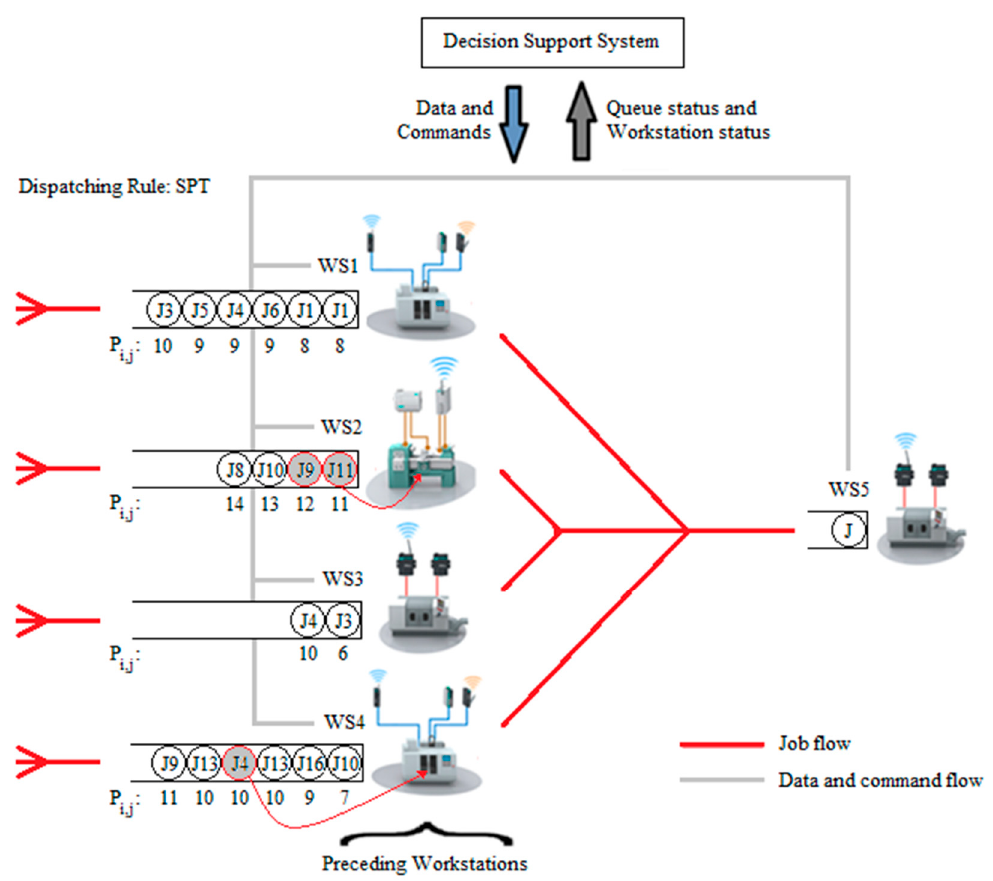
Figure 3. An example of how a Decision Support System (DSS) works.